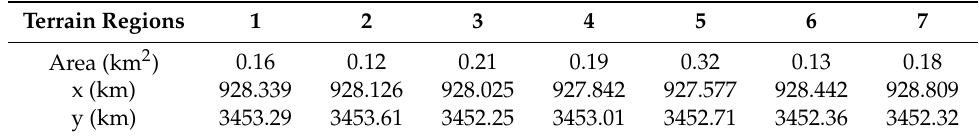
Figure 11. Geomorphological features of the Jijing landslide showing ( a ) front view and ( b ) lateral view (the measuring points are marked with red stars). Table 4. Jijing landslide measurement result.